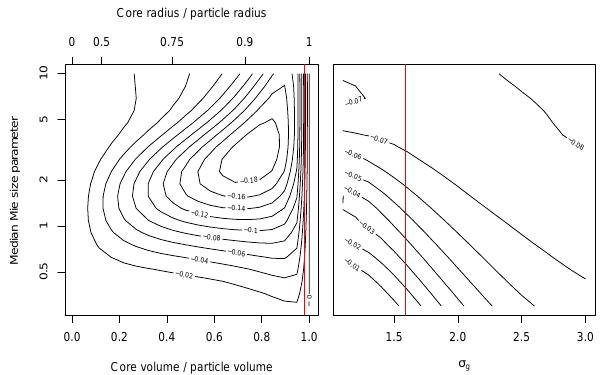
Figure 5. Same as Fig. 4 but with the stronger absorbing component coating the less absorbing component.